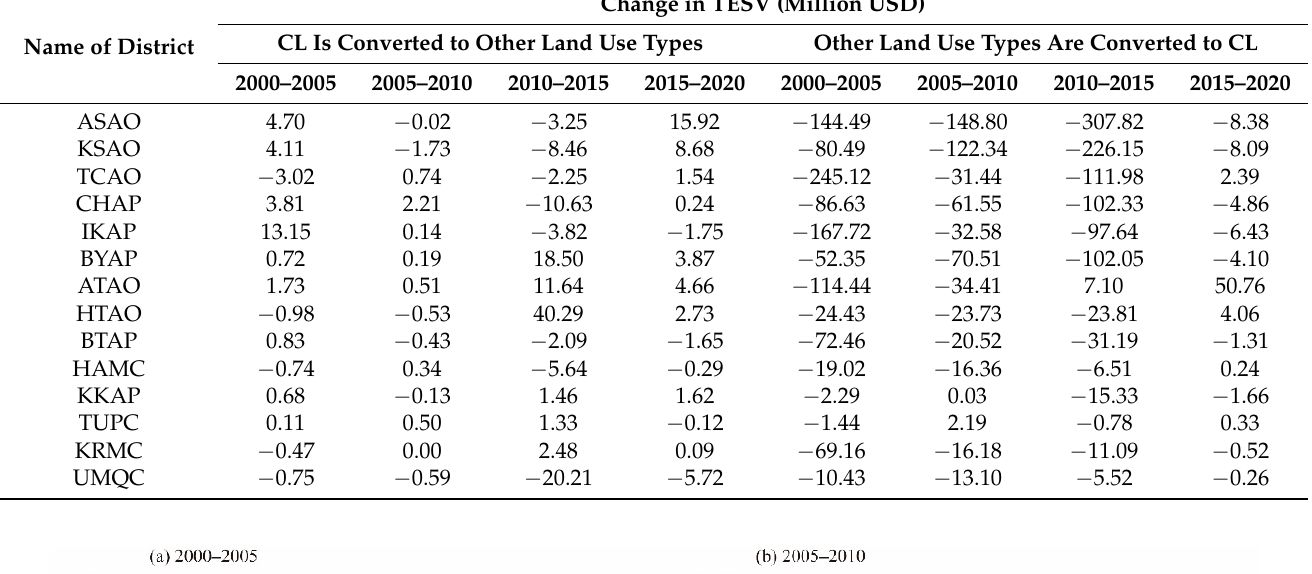
Table 9. Changes in the TESV caused by the conversion of cropland in different prefectures of Xinjiang during 2000–2020.